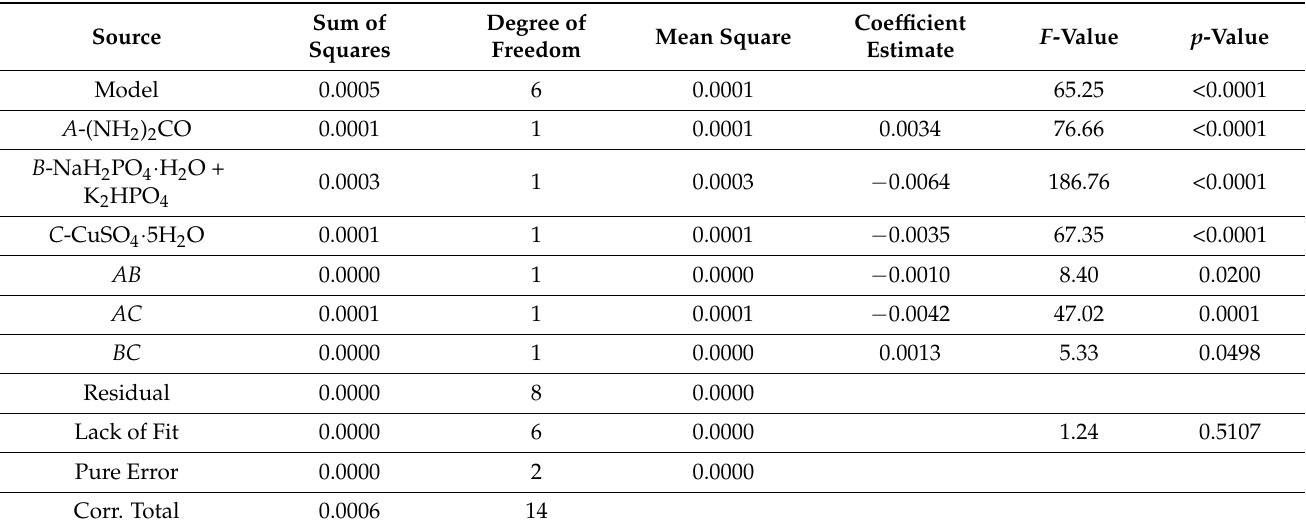
Table 3. Statistical analysis of Box–Behnken experiment for specific growth rates of heterotrophic cultures.